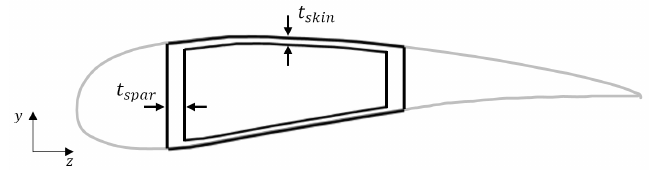
Figure 5. Wingbox section